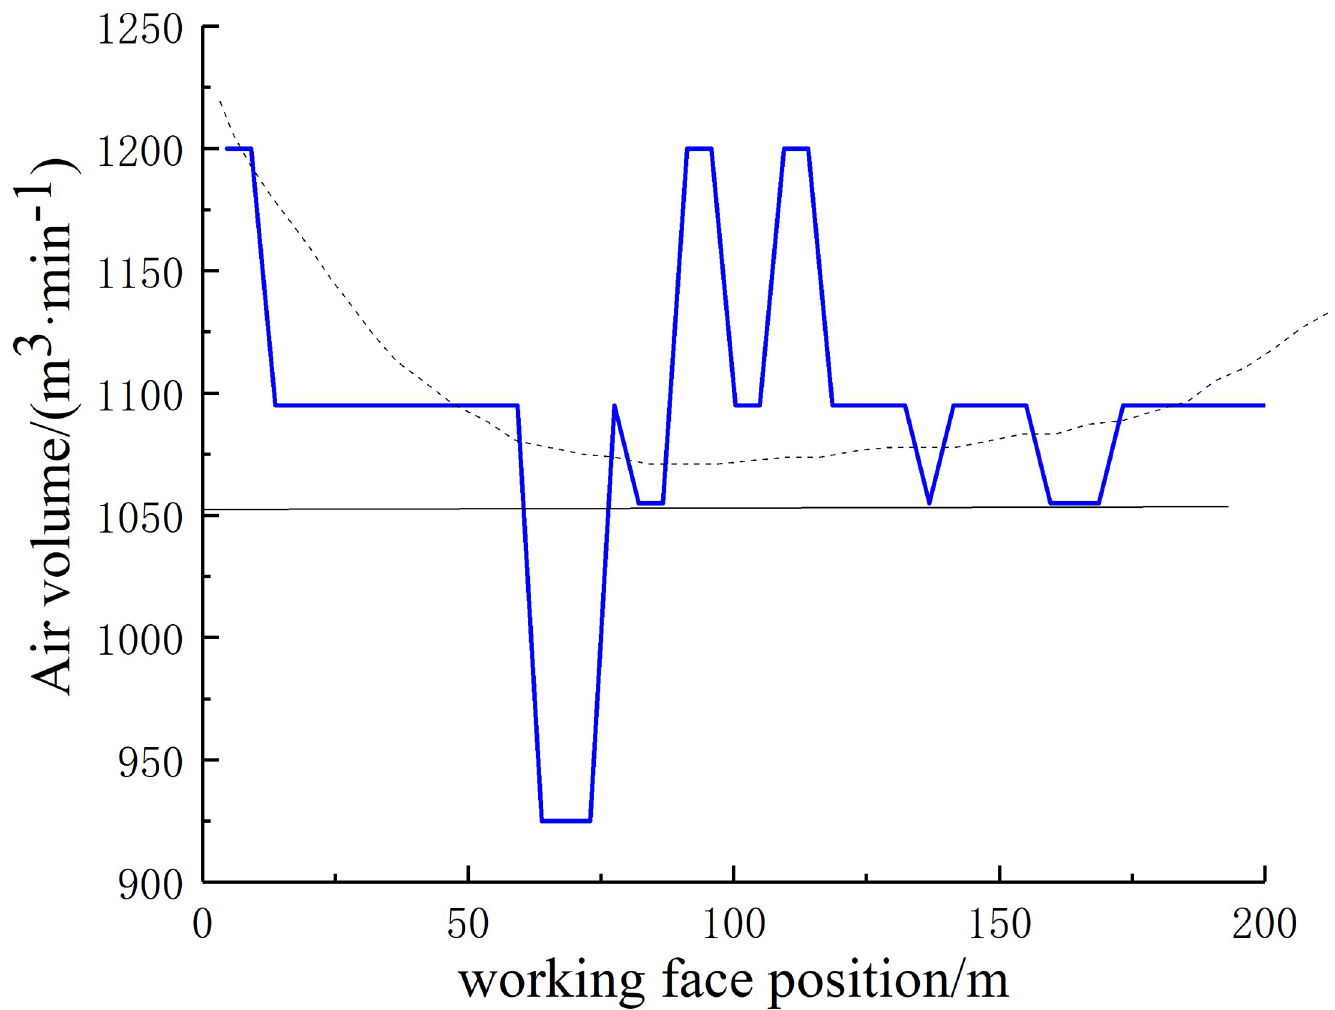
Fig 5. Observation and measurement results of air volume along the 11101 working